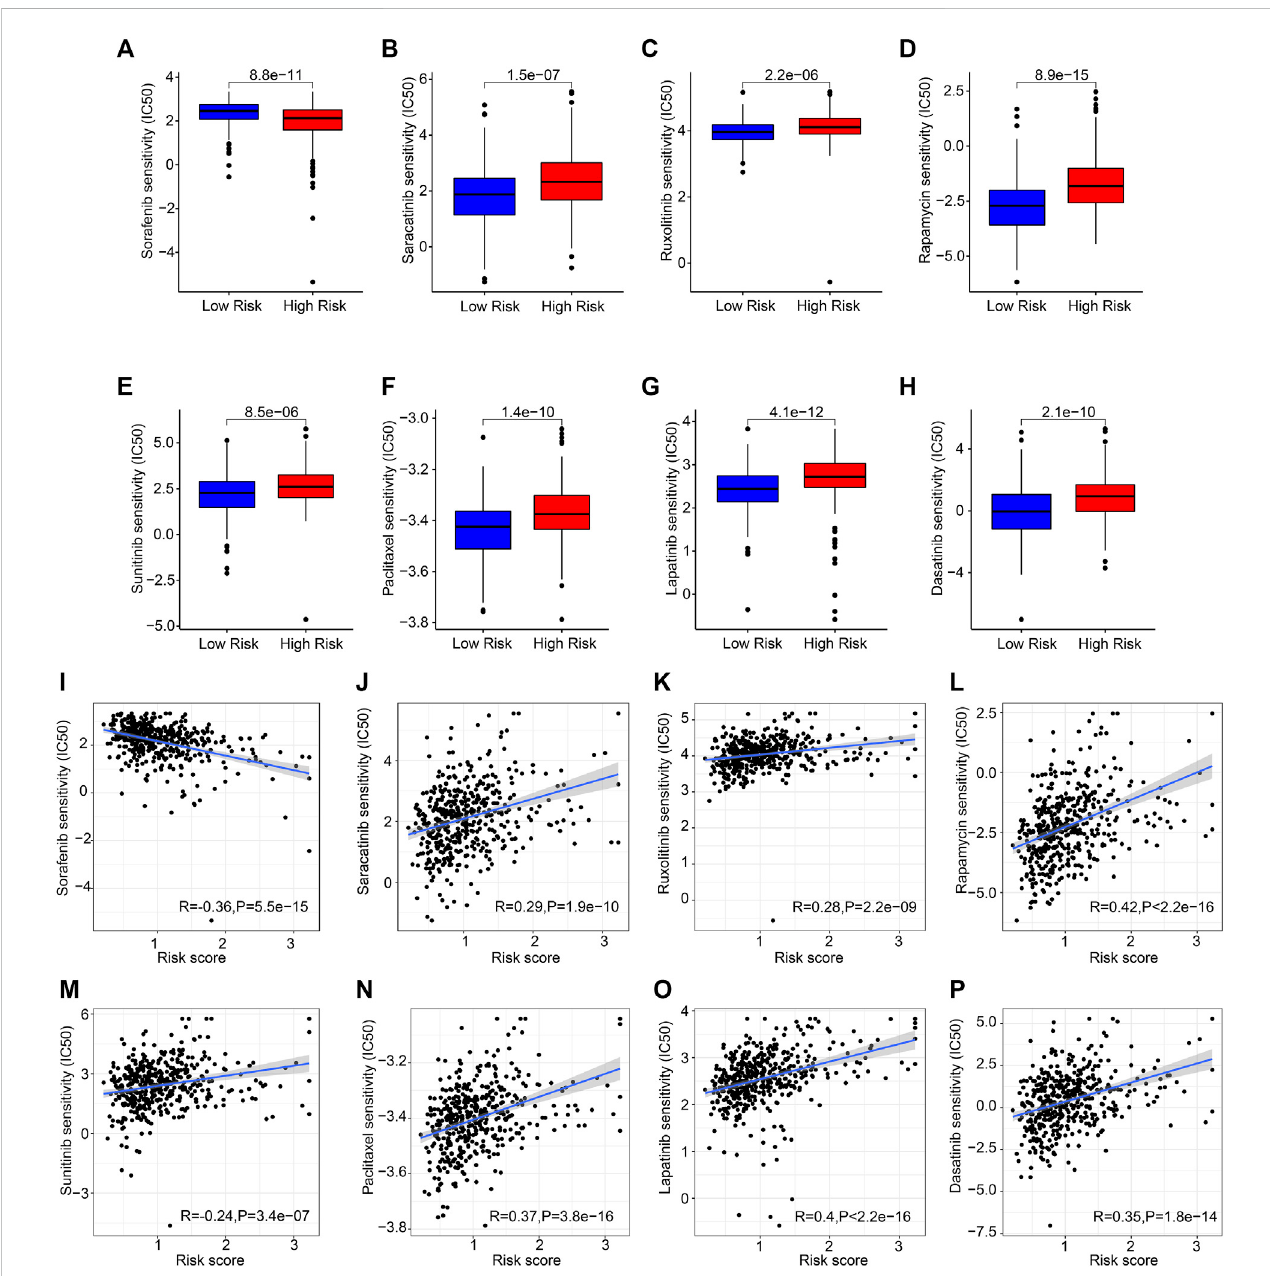
FIGURE 9 Chemotherapyresponseof patients inthedifferentriskgroups. (A) Sorafenib, (B) saracatinib, (C) ruxolitinib, (D) rapamycin, (E) sunitinib, (F) paclitaxel, (G) lapatinib, (H) dasatinib. (I – P) Correlation analysis of the risk score and drug sensitivity (IC50).